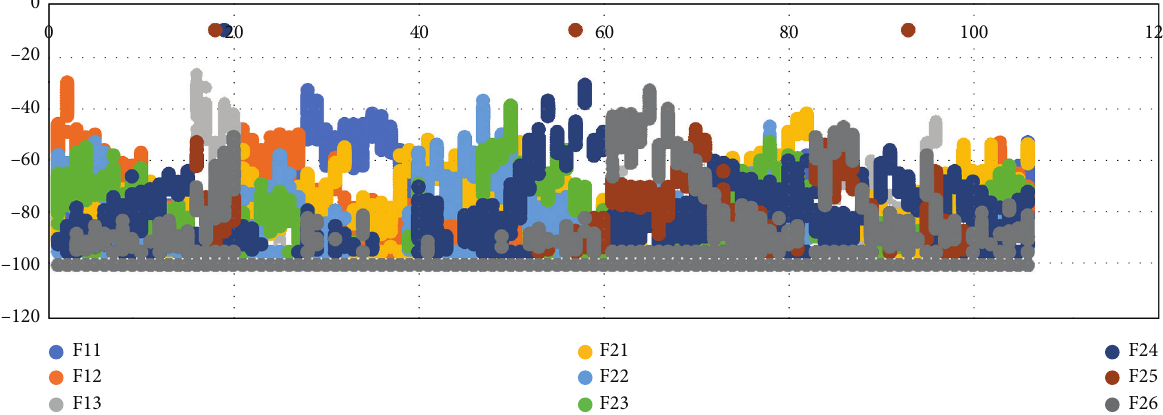
Figure 4: RSS data plot chart. Table 2: The optimizer